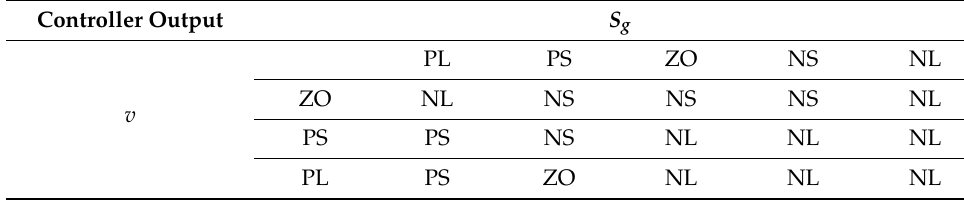
Figure 10. Posture judgment ( 𝑓 𝑓 = L): (a ) 𝑓 𝒅 = S; ( b ) 𝑓 𝒅 = M; ( c ) 𝑓 𝒅 = L.